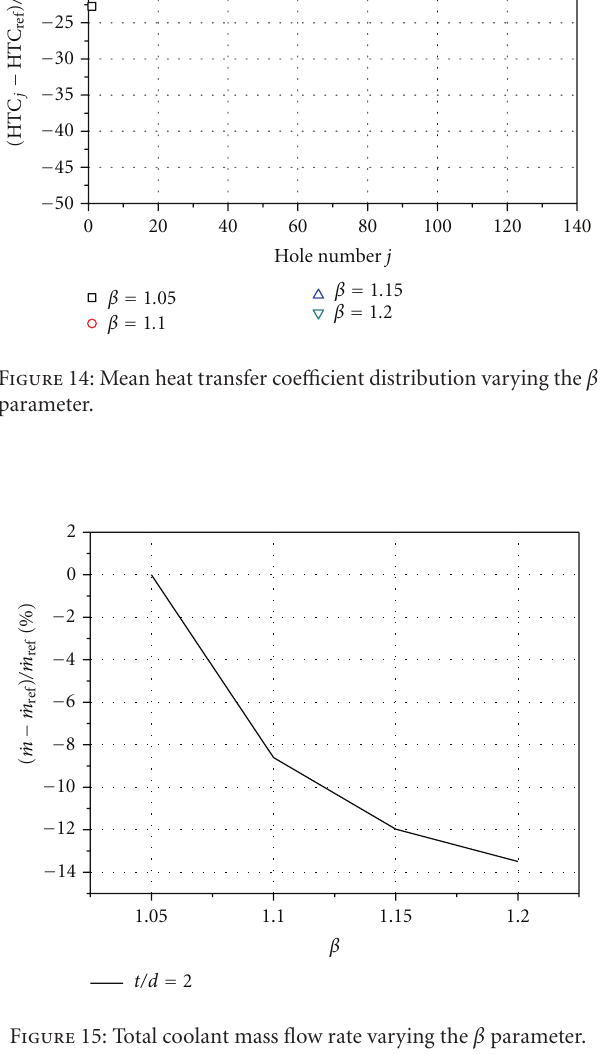
26% higher than those obtained in case of uniform holes’ diameter d = 1 mm.